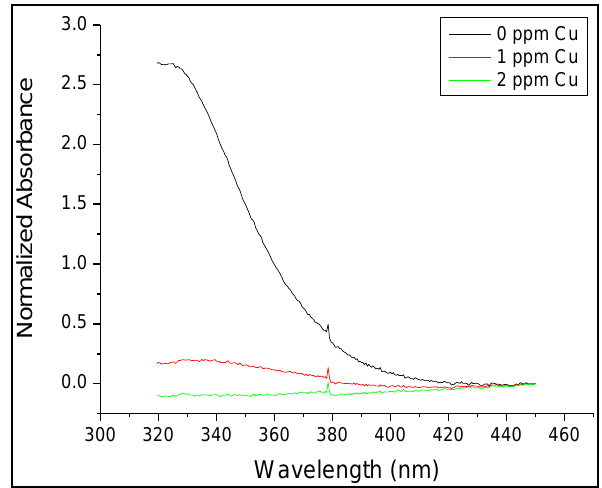
Figure 7. The UV-Vis absorption profile of DDETA attached to a cuvette when exposed to multiple copper-containing